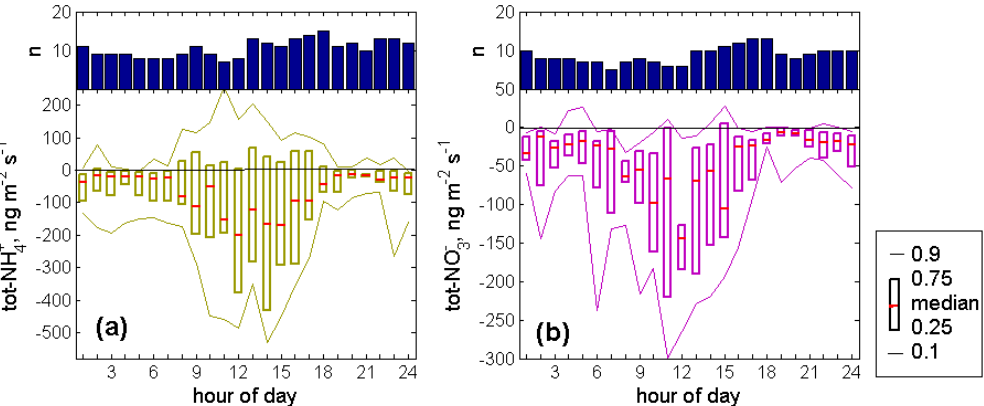
Fig. 6. Median diel variation of (a) tot-NH + flux and (b) tot-NO − flux, ngm − 2 s − 1 (in terms of N), from 1–30 September 2007 at the 4 3 Weidenbrunnen site. Only flux data measured under favourable conditions (no rain, RH < 95%, high visibility) were used. Shown are the medians and inter-quartile ranges (between 25 and 75% percentiles), as well as the 10 and 90% percentiles. The number of data points used for every hour to calculate medians and percentiles are given on top of each graph (blue